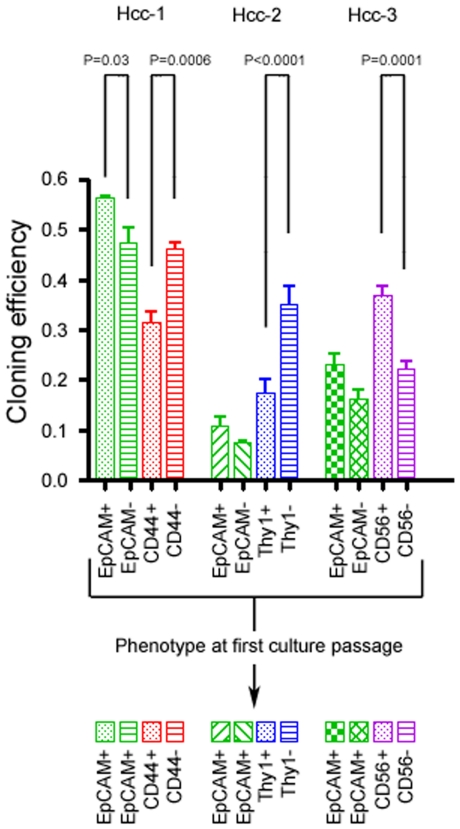
FACS cloning efficiency.Diagrams showing the different clonogenic potential of the 3 primary HCC cell lines sorted for specific membrane markers. Columns (mean and standard deviation of 3 independent experiments) represent the percentage of cells which gave rise to a colony. P<.05 was considered statistically significant (Chi square test). The lower part of the figure reports the expression of the sorting marker on each generated colony. All hcc-1, hcc-2 and hcc-3 colonies were positive for EpCAM regardless of whether they were generated by EpCAM positive or negative sorted cells. The colonies generated by sorting of the other specific markers, i.e. CD44, Thy-1 and CD56, did not show any modification of the expression of these markers.